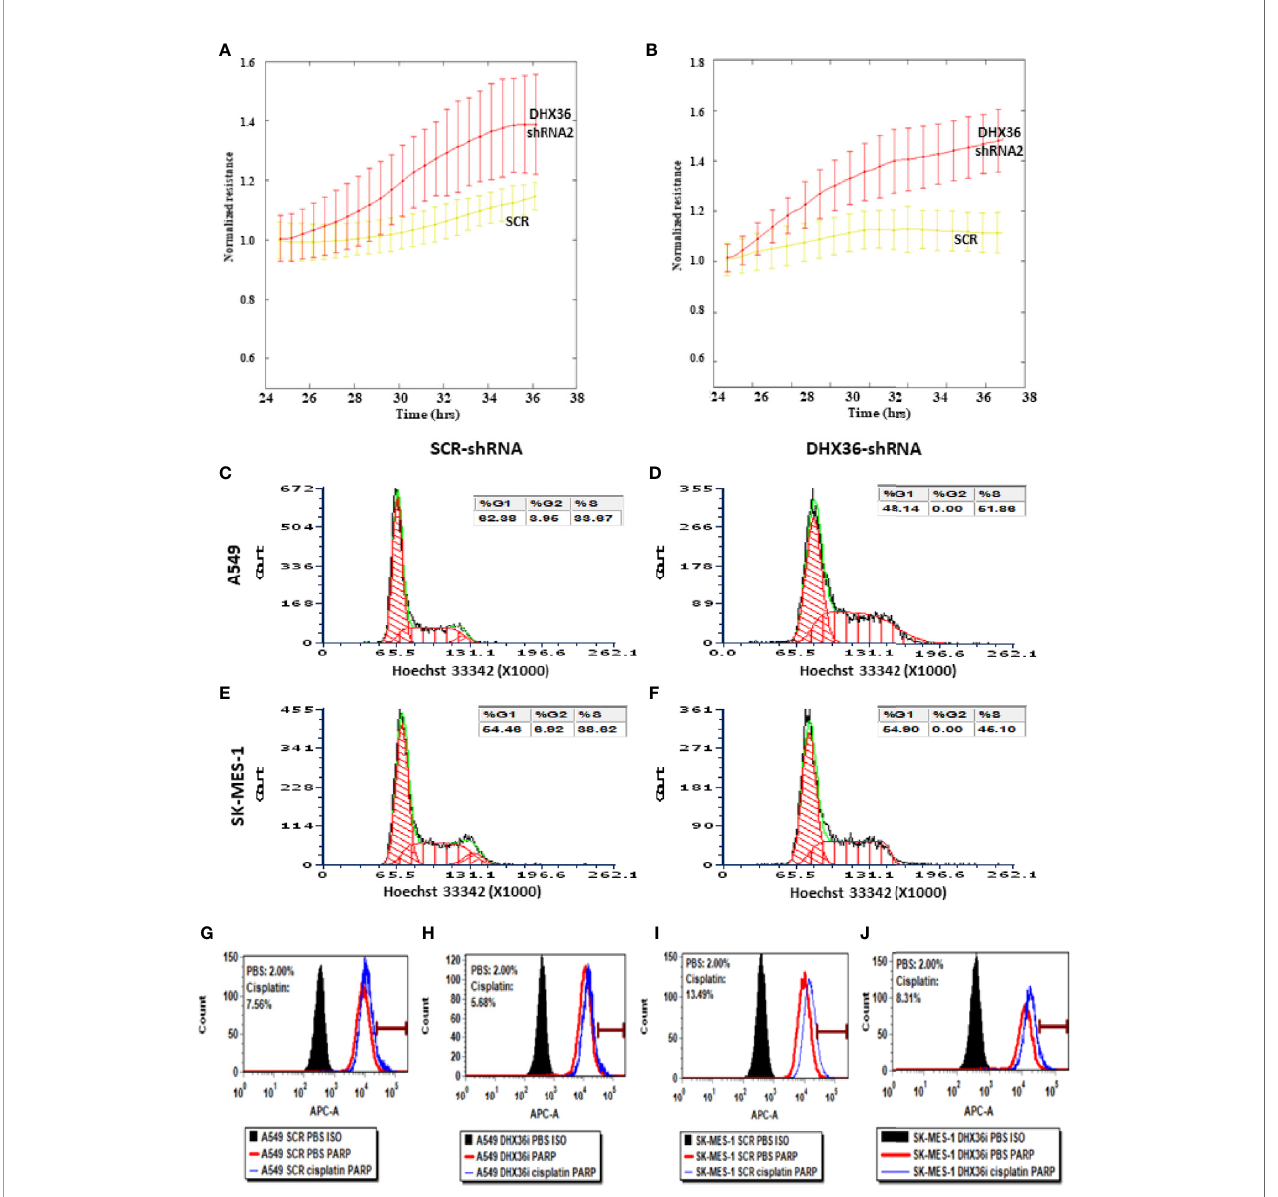
FIGURE 3 | The effect of the knockdown of the DHX36 gene on cell migration, cell cycle and apoptosis. The migration was monitored by the ECIS system in the stable cell lines derived from A549 (A) and SK-MES-1 (B) . (C) Cell cycle analysis of A549 SCR. (D) Cell cycle analysis of A549 DHX36 KD. (E) Cell cycle analysis of SK-MES-1 SCR. (F) Cell cycle analysis of SK-MES-1 KD. (G) Apoptosis of the A549 SCR treated with PBS. (H) Apoptosis of the A549 DHX36 KD treated with cisplatin (10 µM, 24 h). (I) Apoptosis of the SK-MES-1 DHX36 KD treated with PBS. (J) Apoptosis of the SK-MES-1 DHX36 KD treated with